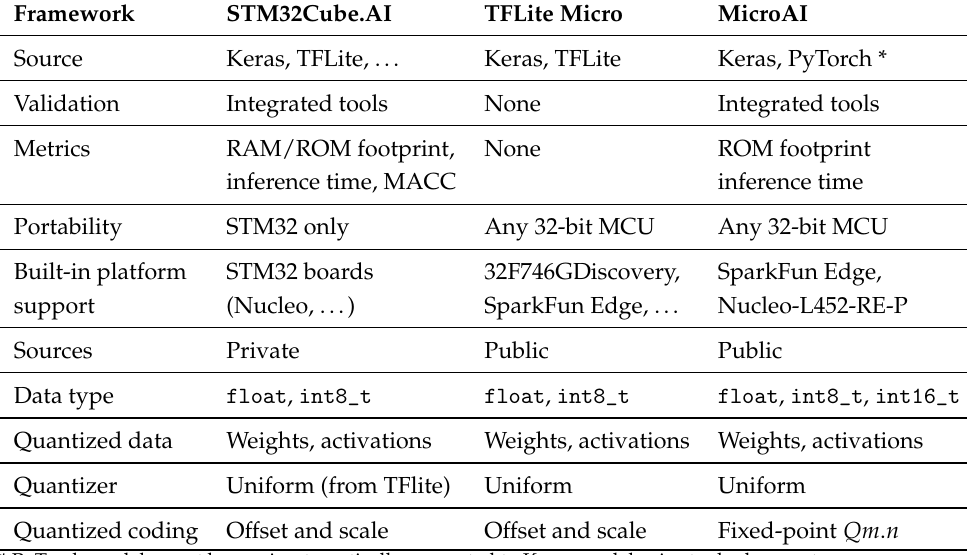
Table 4. Embedded AI